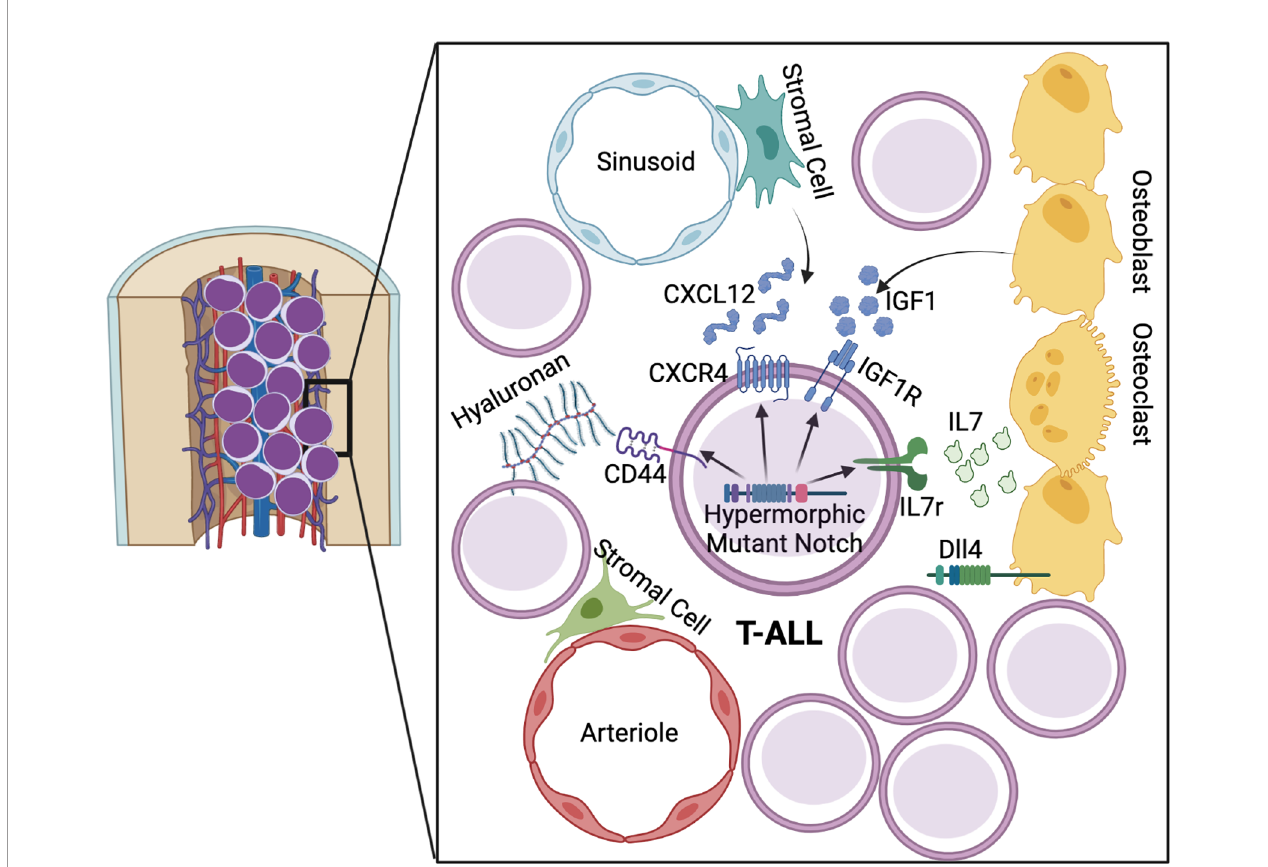
FIGURE 2 | Notch driven mechanisms of T-ALL in the lymphoid niche. Hypermorphic Notch signaling promotes T-ALL progression and ampli fi cation of pathways involved in early BM lymphopoiesis. Growth factor signaling from IL7 and IGF1 are augmented via Notch driven expression of IL7r and IGF1R. CXCR4 and CD44 promote maintenance of LIC blasts in the BM